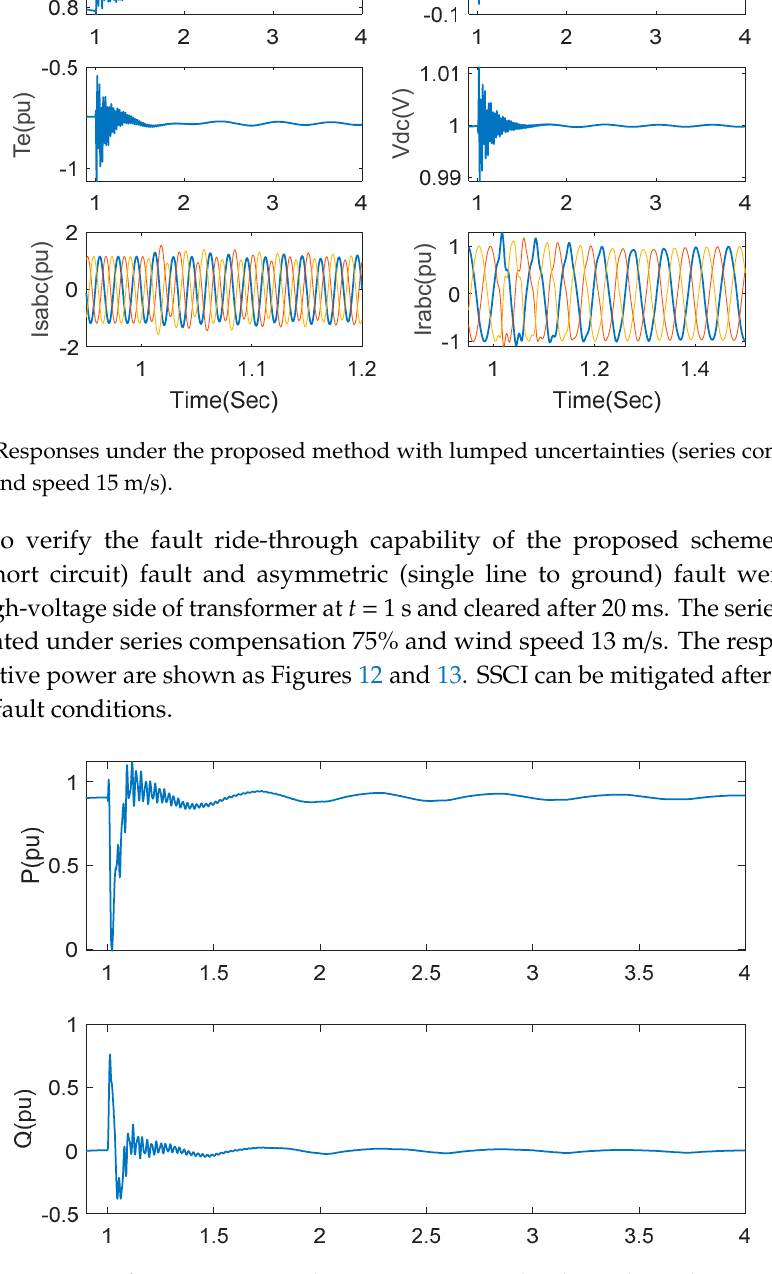
Figure 12. Responses of active power and reactive power under three-phase short circuit fault in series-compensated wind farm.